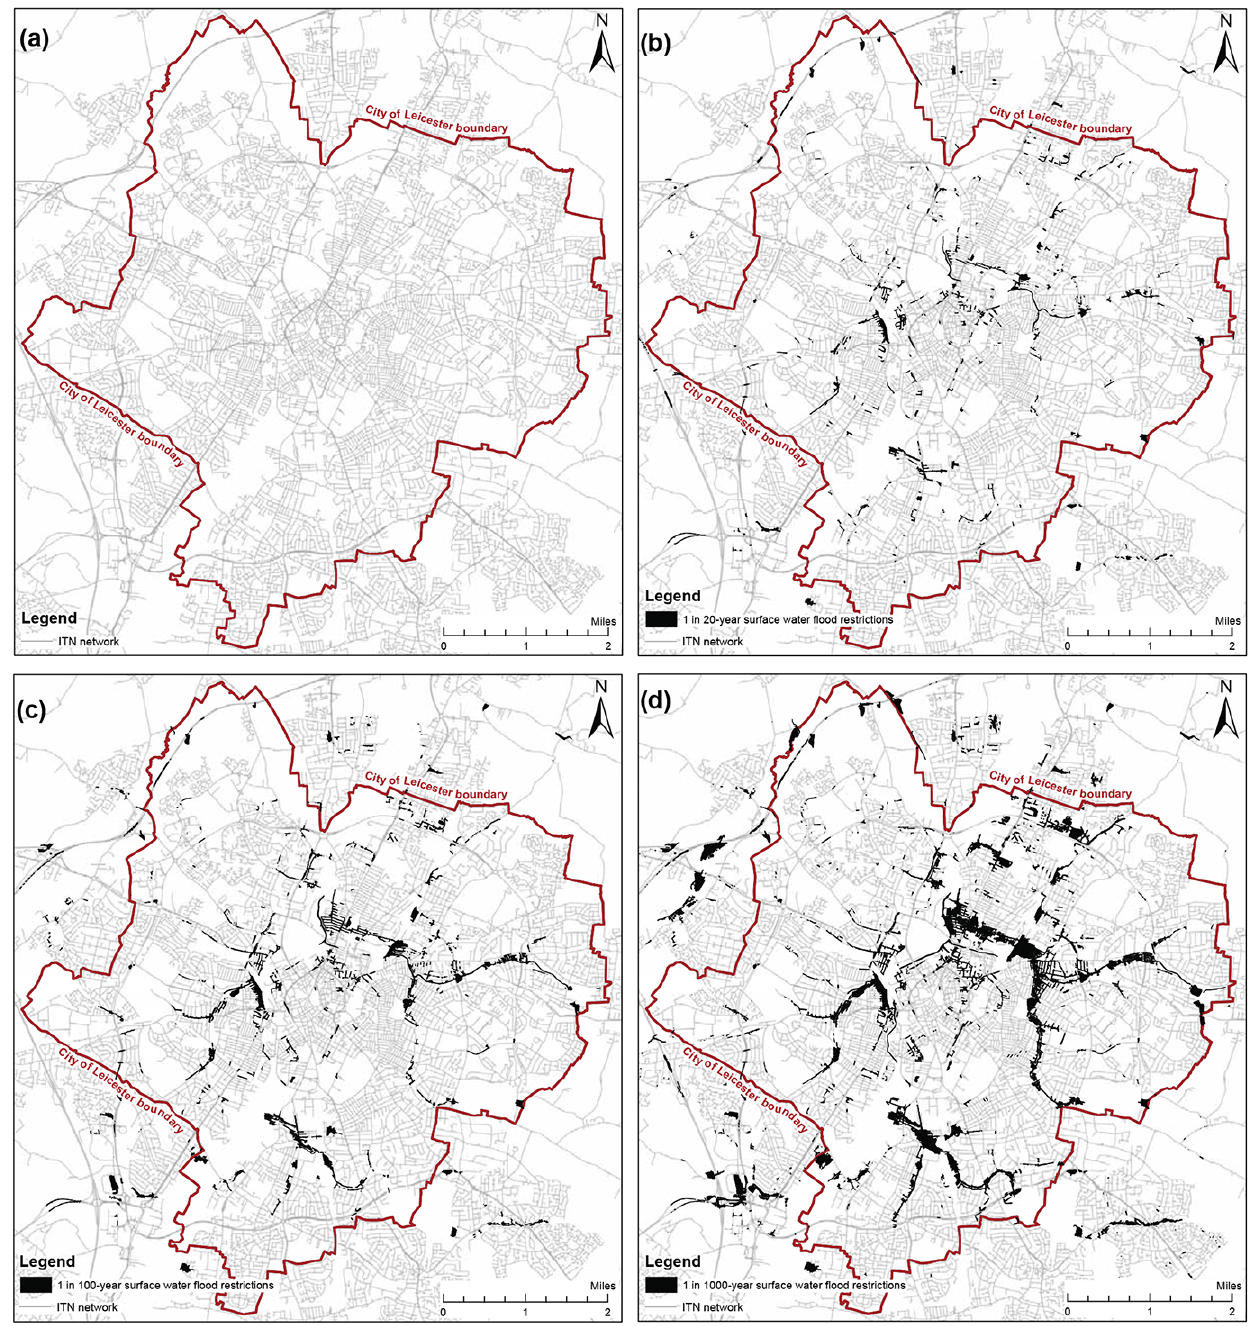
Figure 3. ITN network under (a) normal no-flood conditions and overlain with restrictions under (b) 1 in 20-year, (c) 1 in 100-year and (d) 1 in 1000-year surface water flood scenarios showing the extent of flooding above a 25cm threshold that intersects the ITN